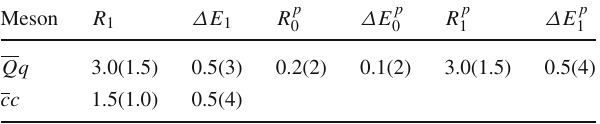
Table 3 Bayesian priors used for two-point correlator fits. For heavy– light mesons, the same priors are used for both heavy quarks Q = c , b . For bottomonium, we present a fit without the excited state, i.e., R 1 = 0 in Eq. (25)